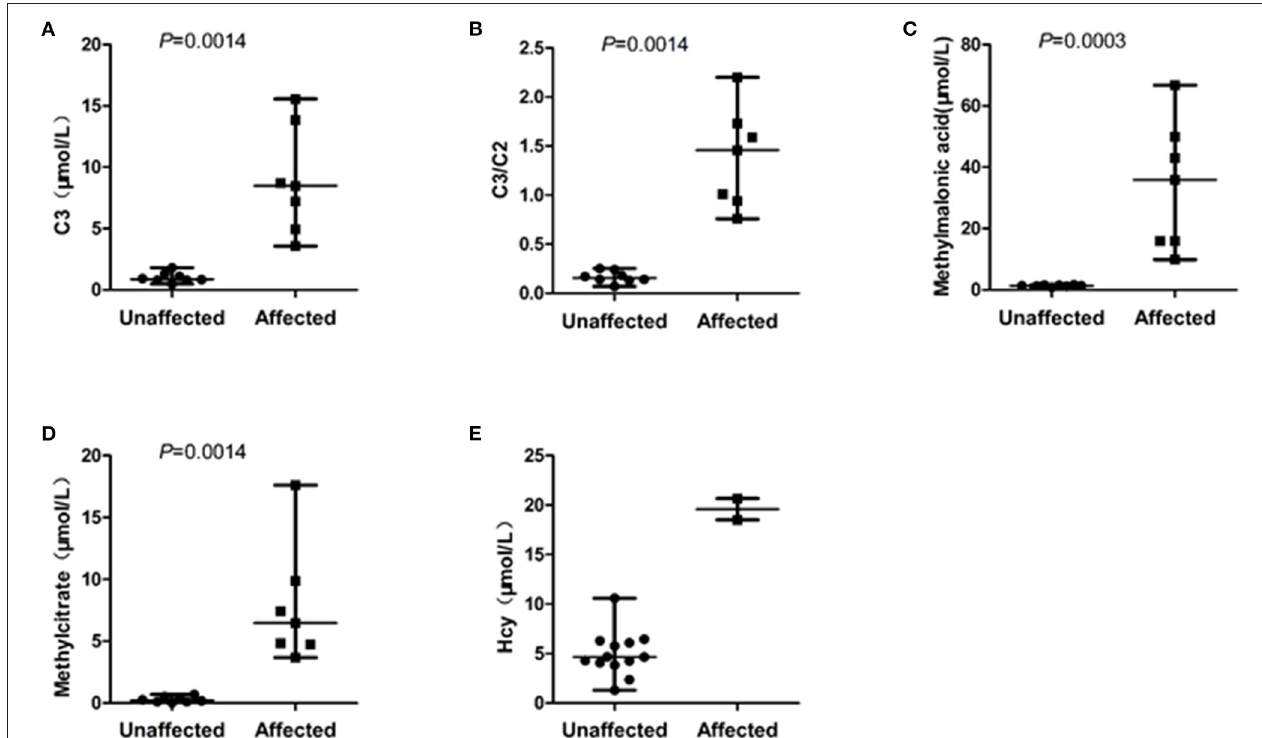
FIGURE 1 | Scatterplot showing the distribution of characteristic metabolite levels in unaffected and affected of 15 cases amniotic fluids referred for MMA. (A) The distribution of C3 levels in amniotic fluids between affected and unaffected samples. (B) The distribution of C3/C2 ratios in amniotic fluids between affected and unaffected samples. (C) The distribution of methylmalonic acid levels in amniotic fluids between affected and unaffected samples. (D) The distribution of methylcitrate in amniotic fluids between affected and unaffected samples. (E) The distribution of Hcy in amniotic fluids between two foetuses with compound heterogeneous MMACHC gene mutations and other amniotic fluid samples unaffected for the MMACHC gene. Horizontal lines, median values. P values were determined by the Wilcoxon rank sum test.